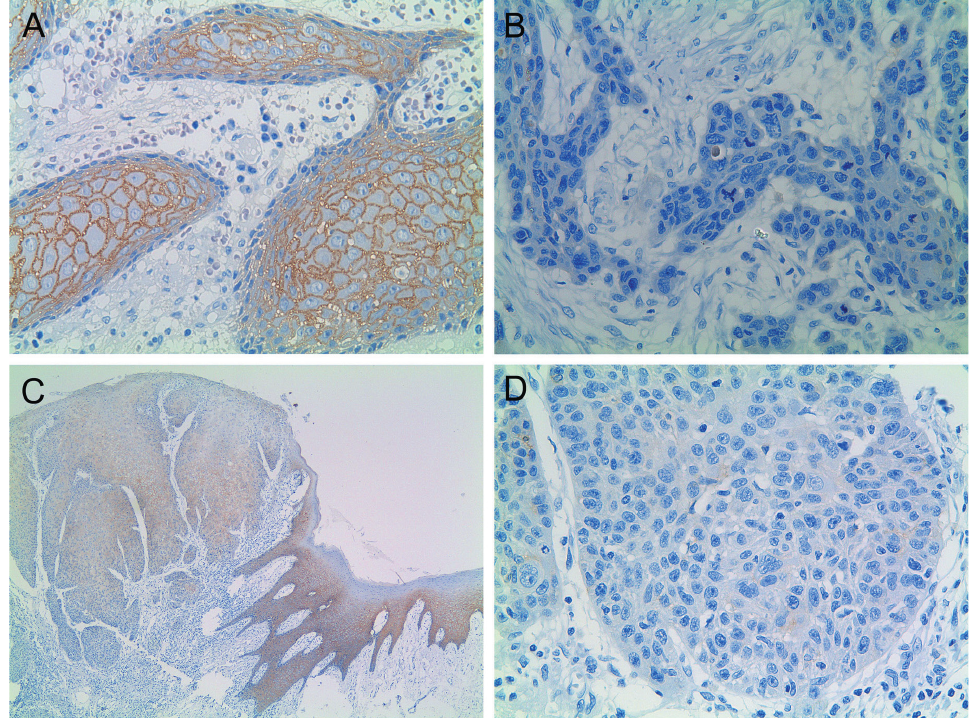
Figure 1- Immunohistochemical reactivity for E-cadherin in oral squamous cell carcinoma (OSCC). A: OSCC displaying preserved E-cadherin expression at the CSA (X400); B: OSCC exhibiting reduced E-cadherin expression at the IF (X400); C and D: OSCC exhibiting preserved E-cadherin expression at the morphologically normal oral mucosa epithelium adjacent to the tumor (C, X40), preserved E-cadherin expression at the CSA (C, X40) and reduced E-cadherin expression at the IF (C, X40; D,